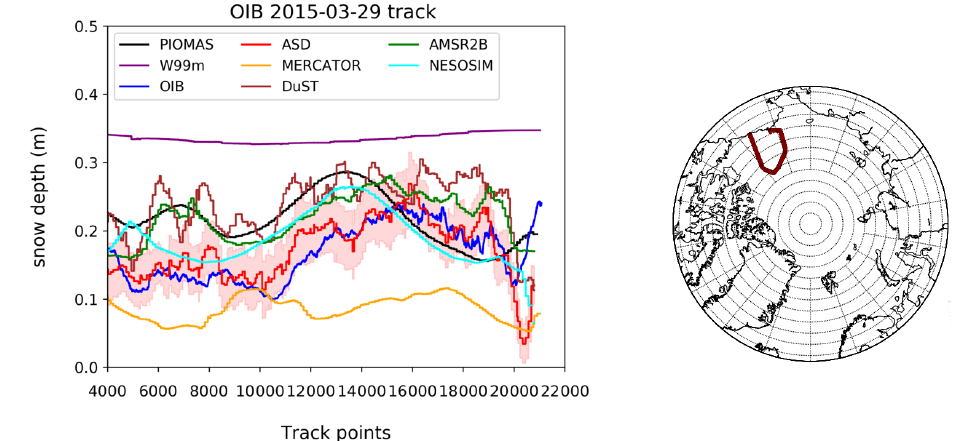
Figure 6. Along-track comparison between the snow depth products and the OIB snow radar data acquired on 29 March 2015 in the Arctic. The red envelope refers to the ASD uncertainties. The geographical map specifies the geographical location of this particular 1d OIB